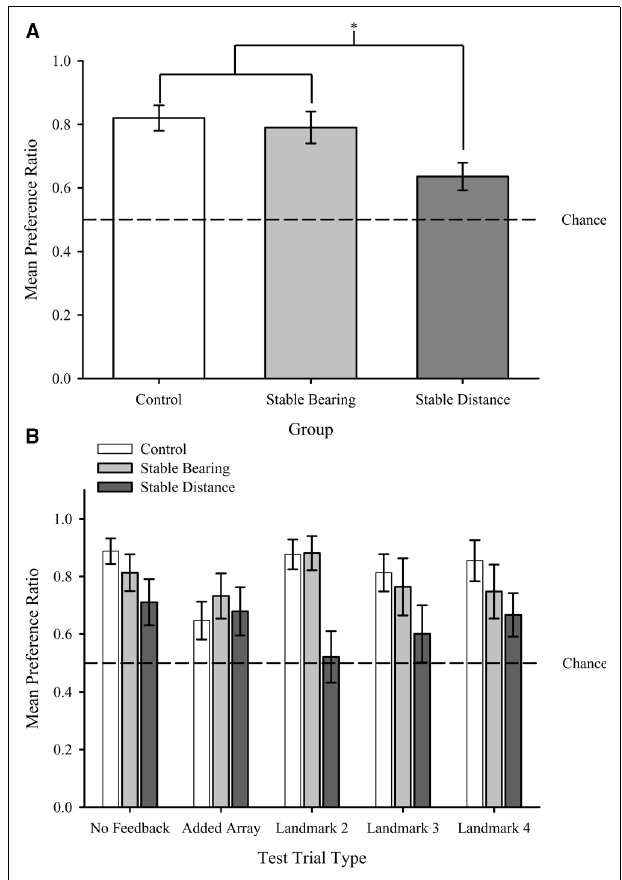
FIGURE 5 | (A) Mean preference ratio plotted by Group collapsed across Test Trial Types (main effect of Group). (B) Mean preference ratio during Testing plotted by Trial Type for each Group. Dashed lines represent chance perfor- mance (0.5). Error bars represent standard errors of the means. (cid:3) p < 0 : 05